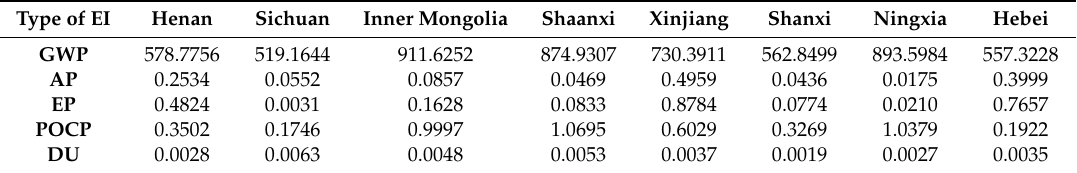
Table5. ImpactpotentialofliquefiednaturalgasproductionintheeightprovincesofChina(perunit / kg). Type of EI Henan